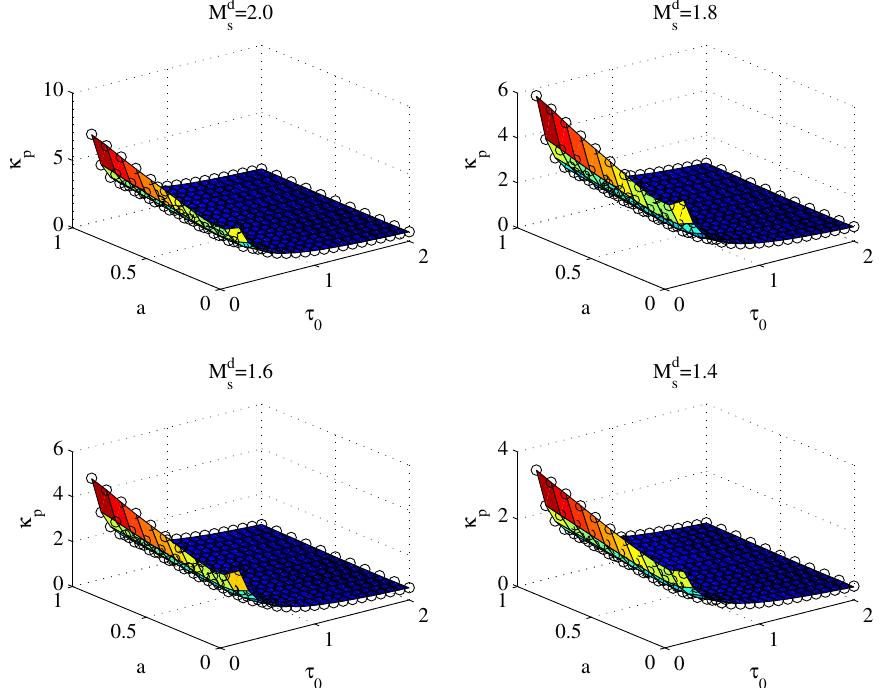
Figure 1. Calculated and approximated optimal κ p in the servo